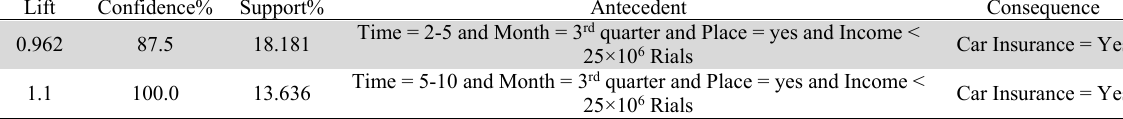
Examples of association rules in the second cluster